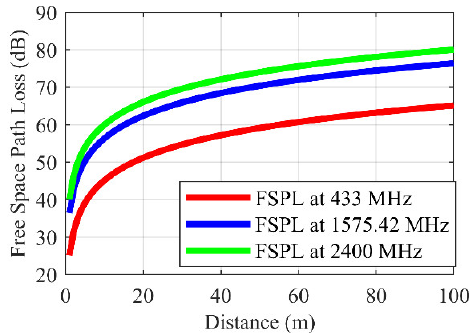
Figure 1. Free space path loss at 2.4 GHz, 1575.42 MHz, and 433